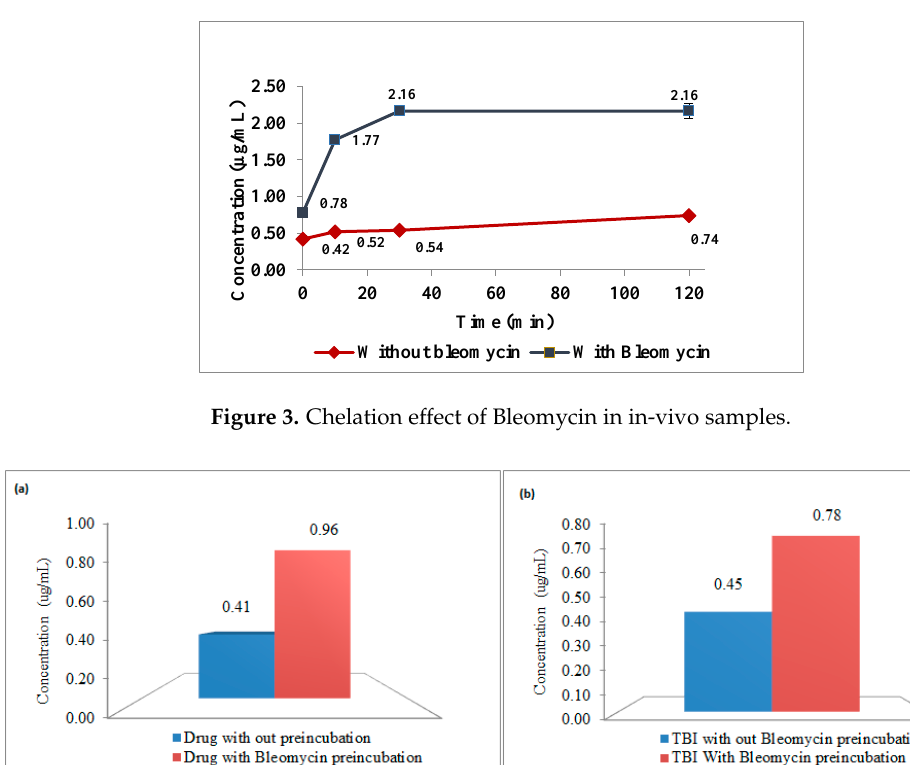
Figure 2. Chelation effects of nitrilotriacetic acid (NTA) and MgCl 2 on Iron colloidal drug with time.